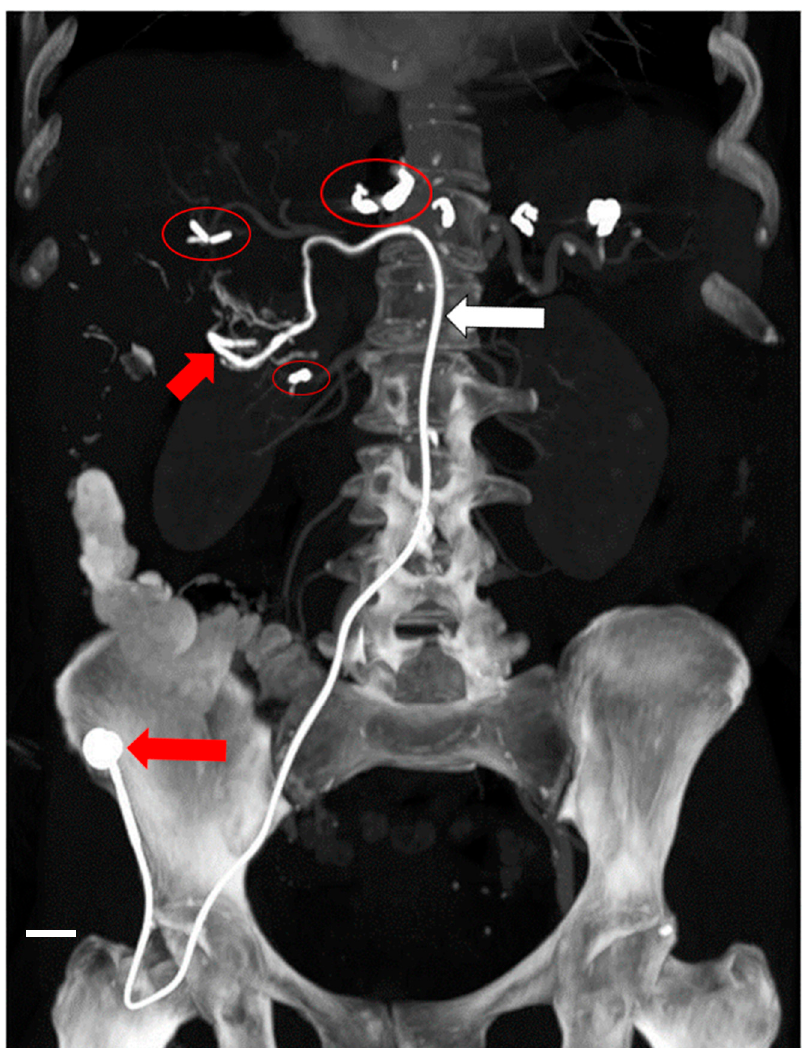
Figure 2. Final presentation of a hepatic arterial port-a-cath system implantation. Red circles indicate embolization by coils and spirals of non-target arterial branches such as artery cystic, gastric arteries, accessory hepatic arteries, and pancreatic-duodenal arteries. The small red arrow indicates the infusion catheter within the proper hepatic artery. The big red arrow corresponds to the infusion chamber of the port-a-cath system. Scale bar equals 1 cm.